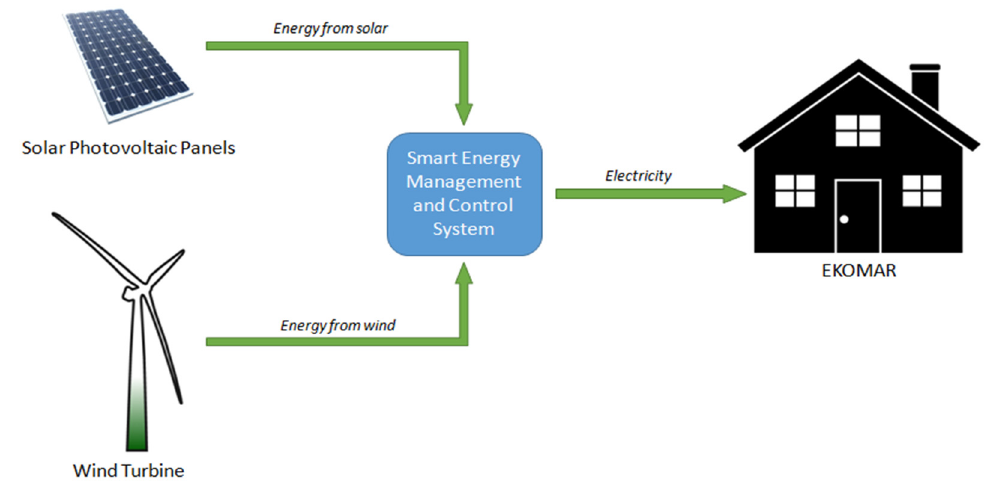
Figure 5. EKOMAR hybrid wind–solar renewable energy generation system. Malaysia is a tropical country with more than 10 h of sunshine a day throughout the year